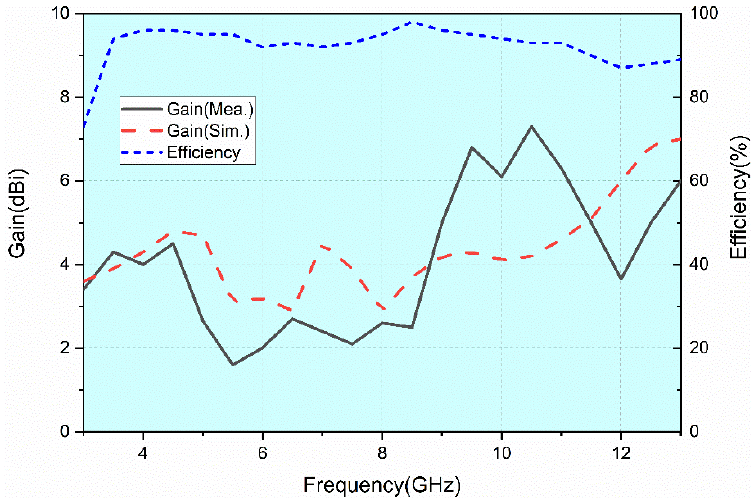
Figure 15. Antenna gain and radiation efficiency. Table 2. Comparison of the stated UWB MIMO antennas within recent studies.